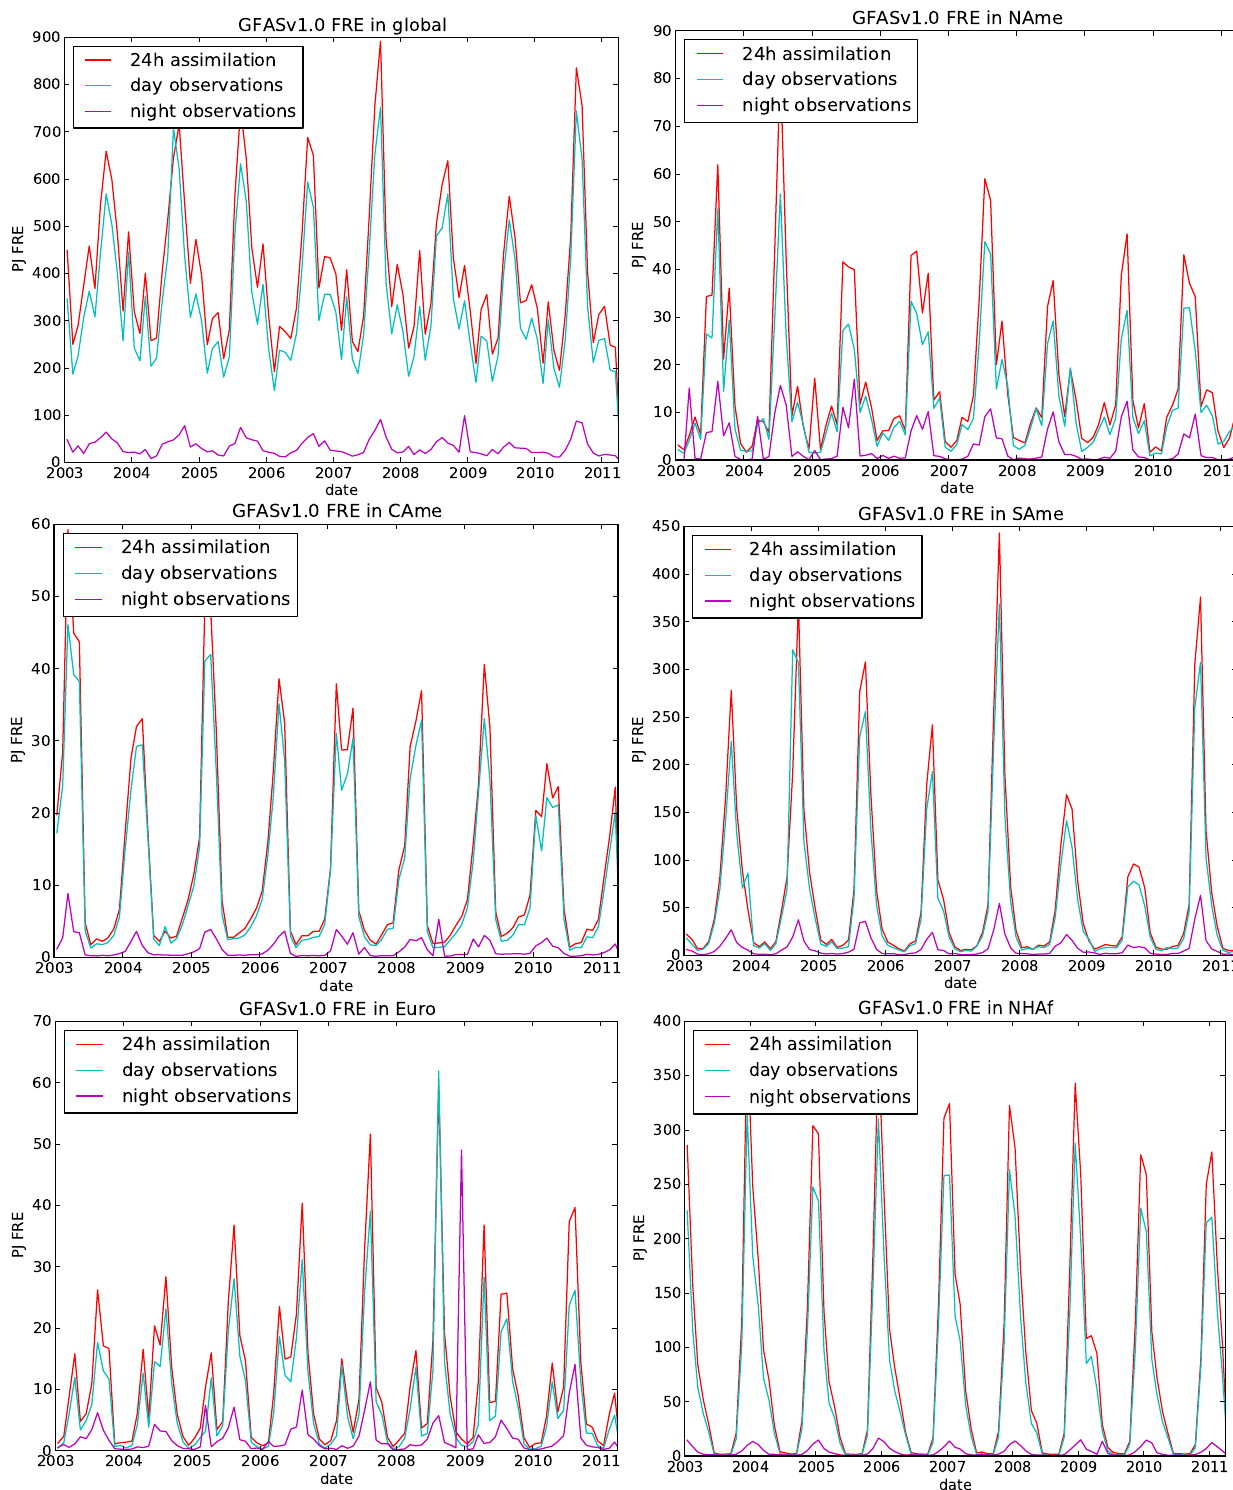
Fig. 4. Monthly fire radiative energy (FRE) observed by MODIS as used in GFASv1.0 for the entire globe and for several regions as defined in Table 4. Also shown is the subsequent FRE analysis (“24h